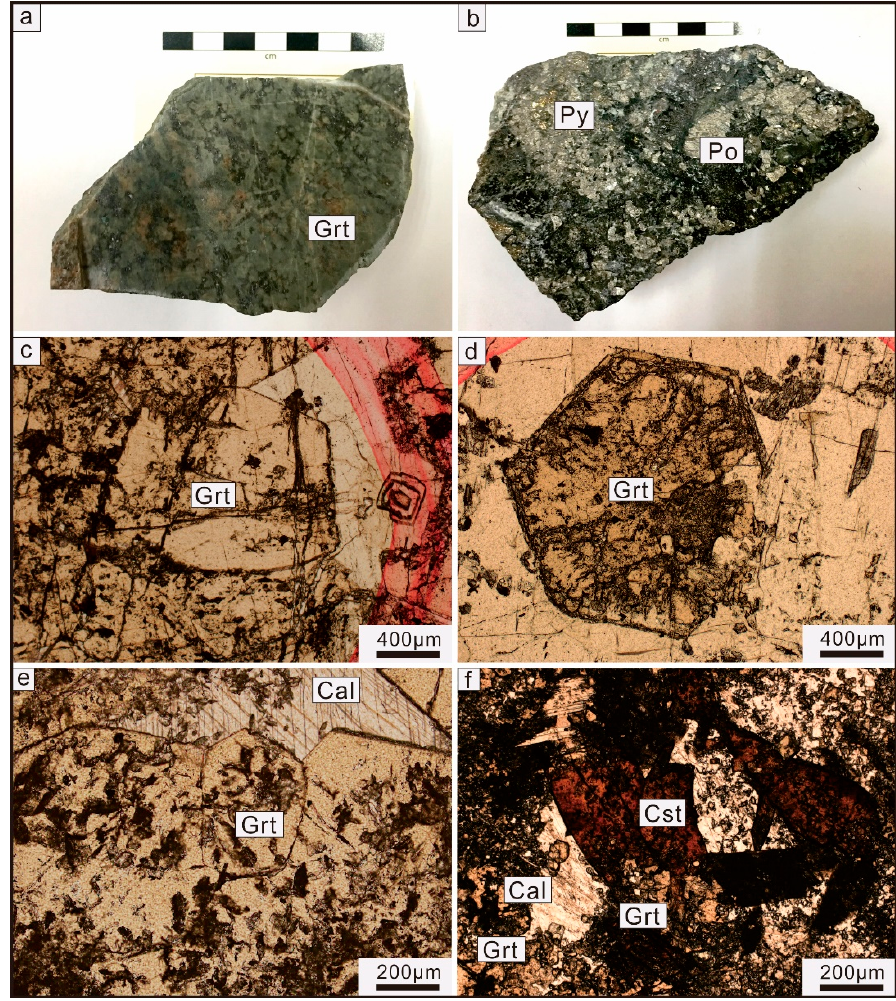
Figure 3. Photos of hand specimens and thin sections of samples from the Xianghualing skarn Sn deposit. ( a ) Massive garnet-bearing skarn in reddish brown; ( b ) massive sulfide ore containing pyrite and pyrrhotite; ( c ) an euhedral garnet crystal; ( d ) an euhedral garnet hydrothermally altered by later retrograde minerals; ( e ) the gaps between garnet grains filled with later calcite; ( f ) garnet grains postdated by later calcite and cassiterite. Abbreviations: Cal = calcite; Cst = cassiterite; Grt = garnet; Po = Pyrrhotite and Py = Pyrite.